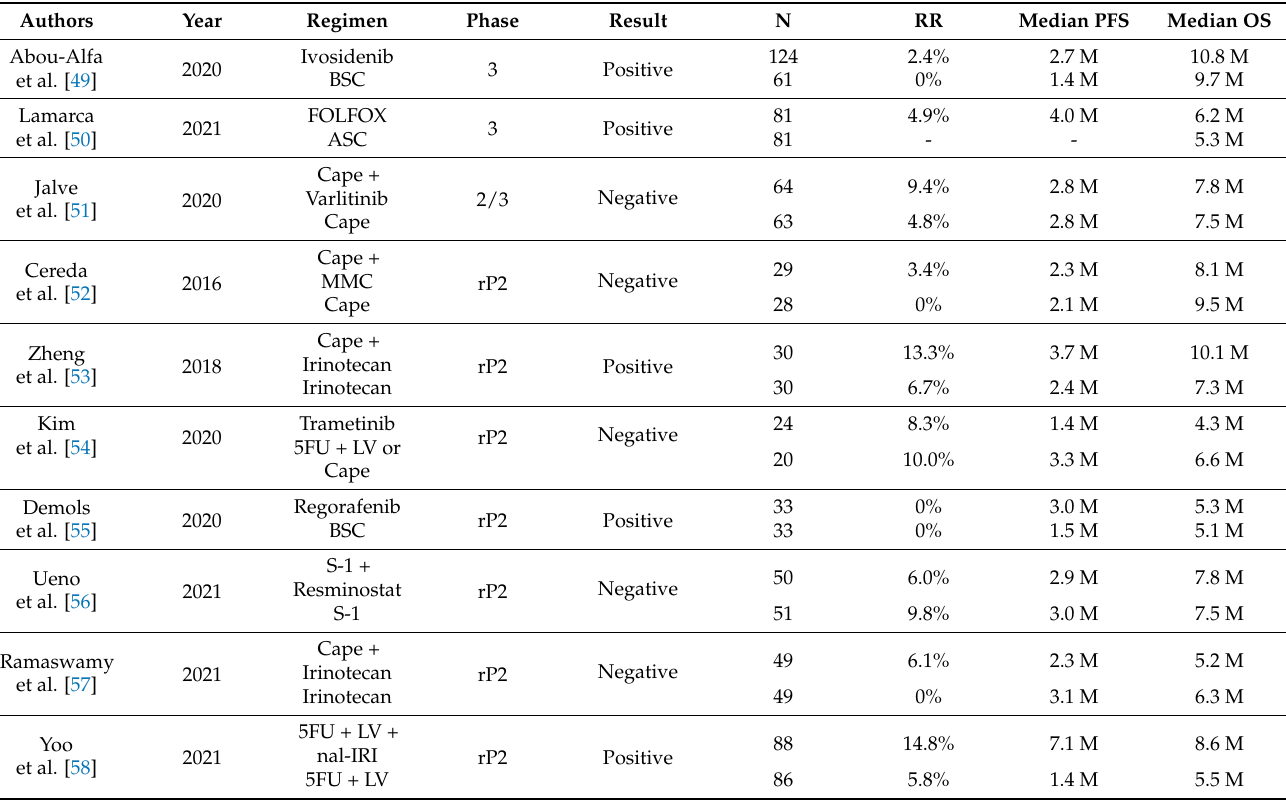
Table 2. Randomized controlled studies on second-line or third-line chemotherapy for advanced biliary tract cancer.